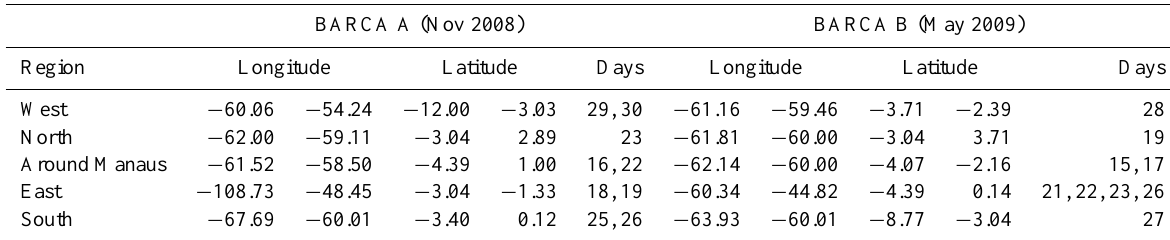
Table 6. Longitude and latitude bounds and dates for each region of the BARCA A and B